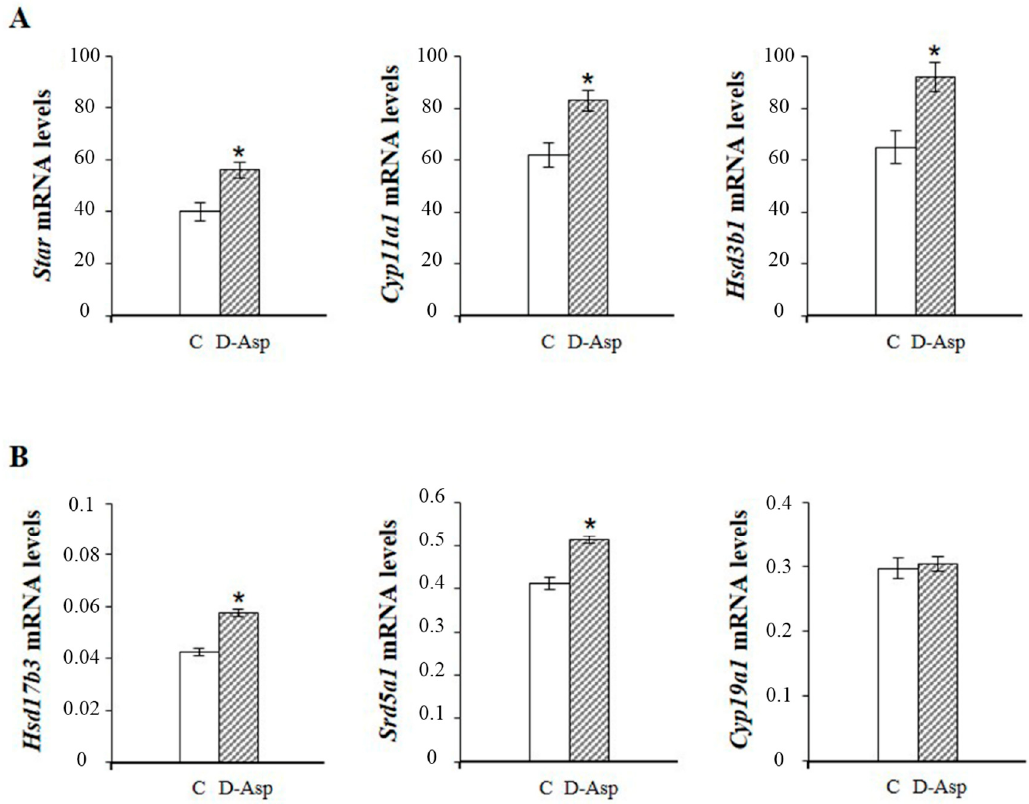
Figure 3. ( A ) qRT-PCR analysis of Star , Cyp11a1 and Hsd3b1 in the testis from D -Asp-treated rats and controls. The animals were allowed to drink 20 mM D -Asp ad libitum for 15 days (chronic treatment); ( B ) qRT-PCR analysis of Hsd17b3 , Srd5a1 and Cyp19a1 in the testis from D -Asp-treated rats and controls. The animals were injected i.p. with 2.0 µmol D -Asp/g body weight (acute treatment). Values represent the mean ± SD of five samples. * p < 0.05.